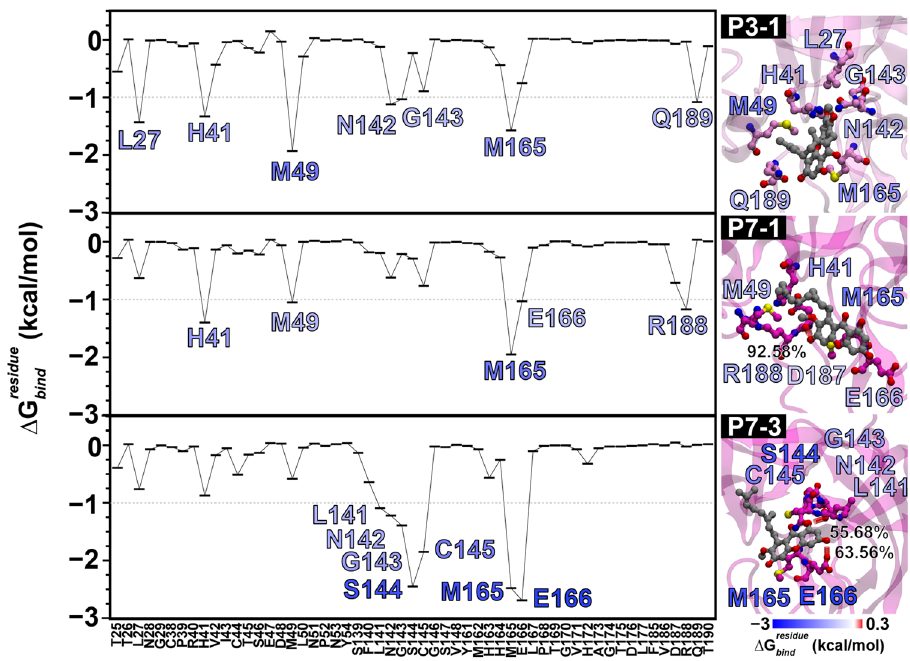
Figure 8. Interaction profile and key binding residues for rubraxanthone binding at M pro active site in top three clusters: P3-1, P7-1, and P7-3. Residues exhibiting (cid:31) G figure